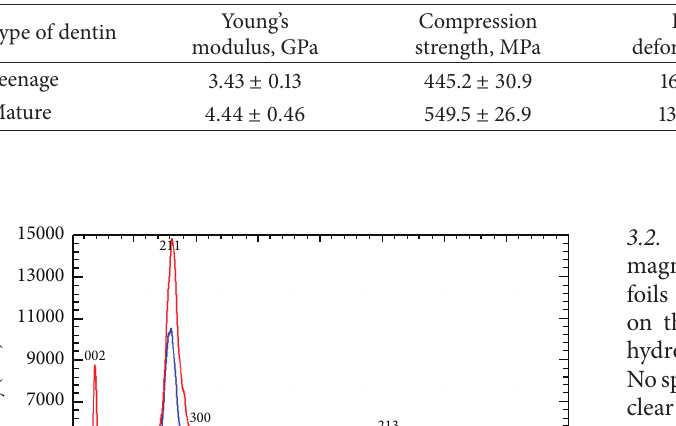
Table 1: The mechanical properties with standard deviation of teen and mature age dentin under compression.